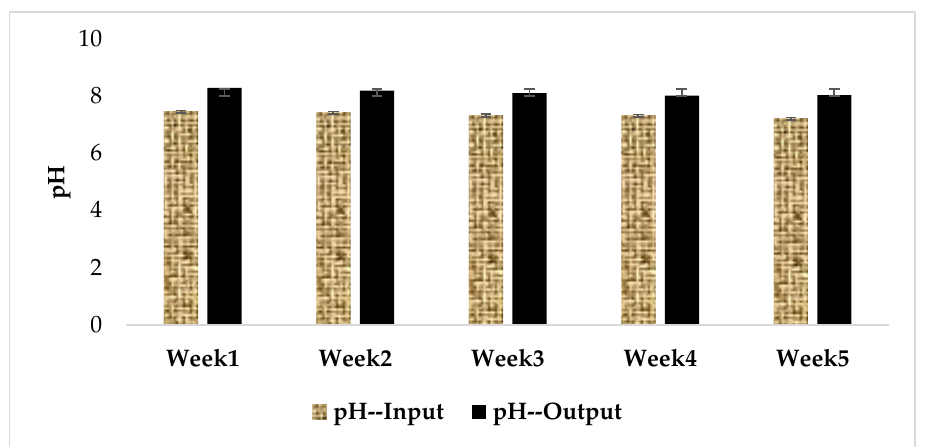
Figure 2. pH at the influent and effluent of the MSL pilot plant during the experiment. The highest values of dissolved oxygen were 4.31 ± 0.20 mg/L and 4.81 ± 1.72 mg/L at the inlet and outlet, respectively, and the lowest values were 2.11 ± 0.12 and 2.13 ± 1.37 mg/L at the inlet and outlet, respectively. As shown in Figure 3, the Mann – Whitney test showed no significant difference between the input and output of the MSL system.